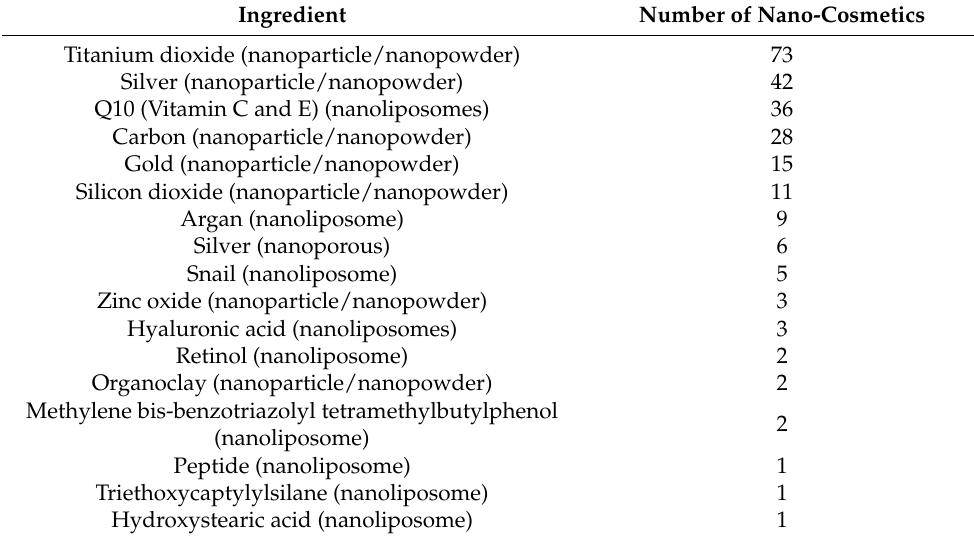
Table 8. Nanomaterials featured in cosmetic products available in Europe